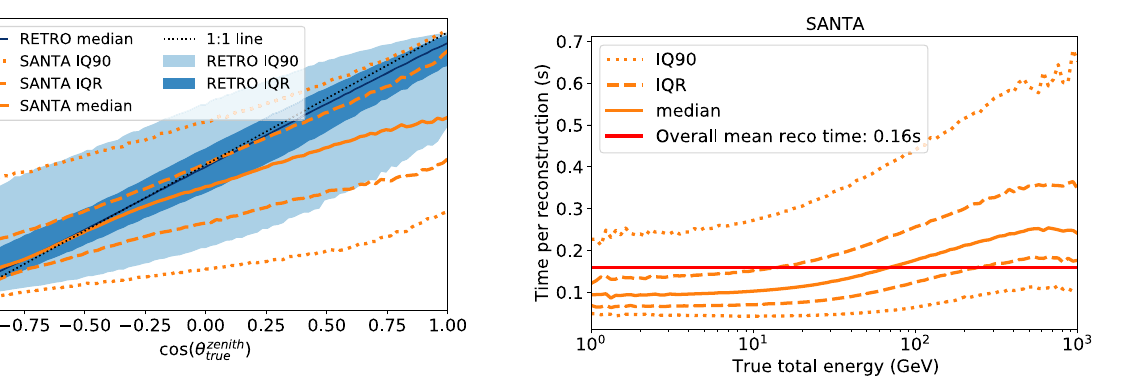
Fig. 17 Reconstructed versus true cosine zenith values for retro (blue) and santa (orange). The median is shown as well as the 50 and 90 percent interquantile range (denoted as IQR and IQ90)